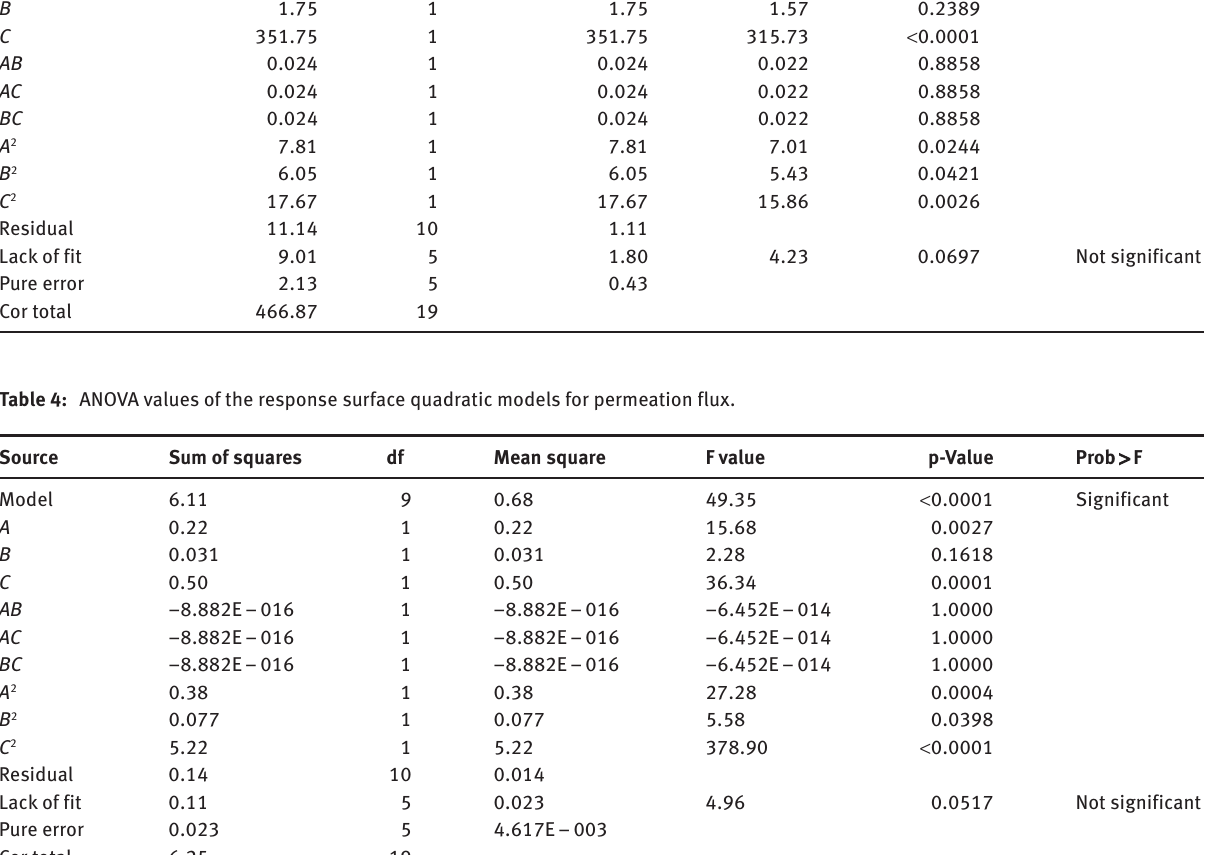
Separation factor ( α ),